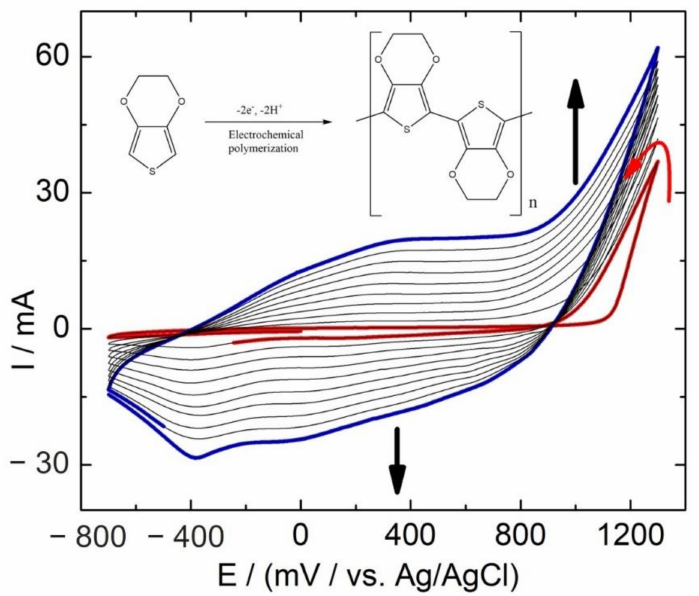
Figure 2. Cyclic voltammograms recorded during 10 cycles of EDOT electropolymerization in the potential range from − 0.7 to 1.3 V on 304 SS at 0.05 V · s − 1 from a 0.1 mol · L − 1 EDOT + 0.1 mol · L − 1 LiClO4 solution, in CH3CN. Inset: Proposed electrochemical polymerization mechanism of